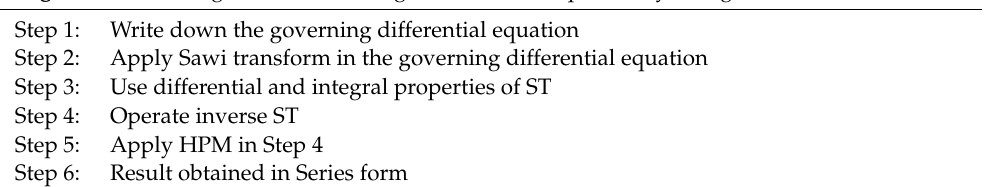
Algorithm 1. An Algorithm for Solving a Differential Equation by Using